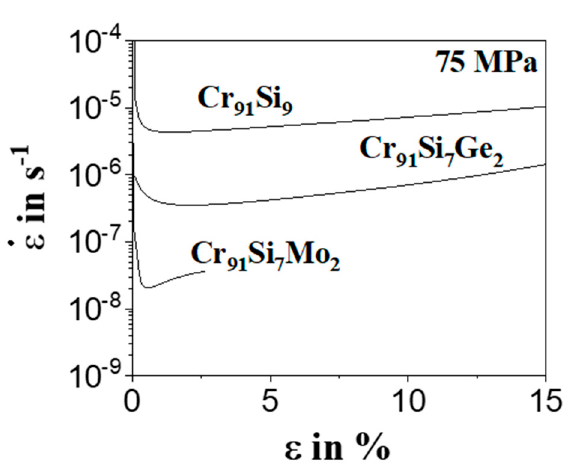
Figure 3. Strain rate vs. strain curve for the three alloys with a load of 75 MPa.